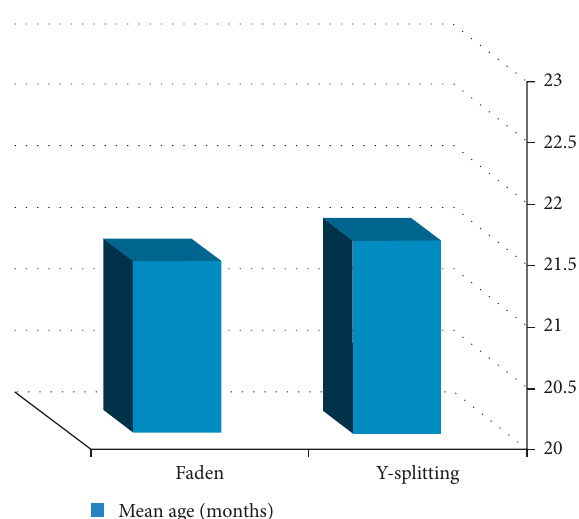
Figure 3: Patients’ profile showing patients’ distribution by age.